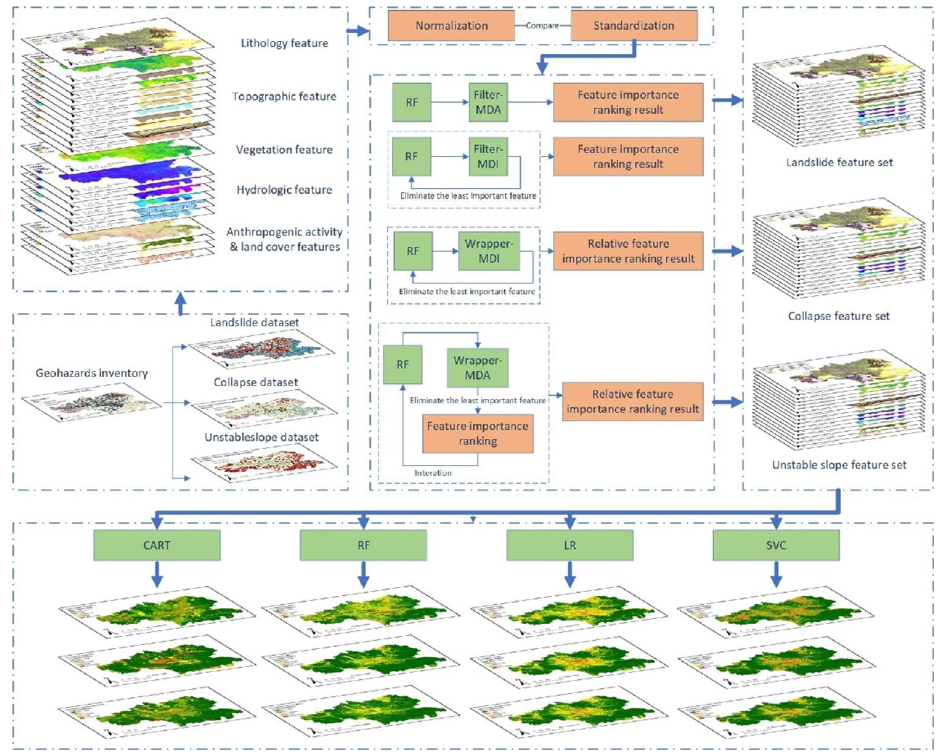
Figure 1. Workflow of this study .